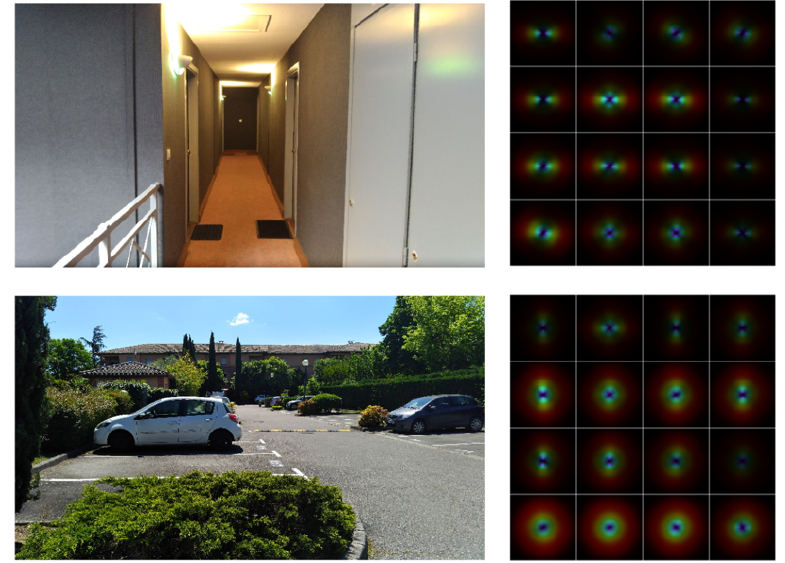
Figure 6. Original image and its GIST representation (indoor example on the top , outdoor example on the bottom